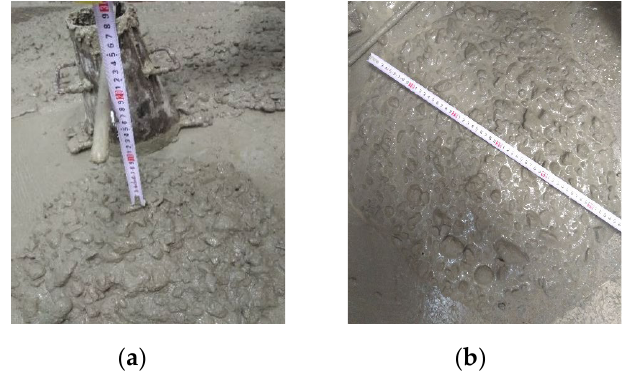
Figure 3. Flowability measurement: ( a ) slump; ( b ) slump flow.